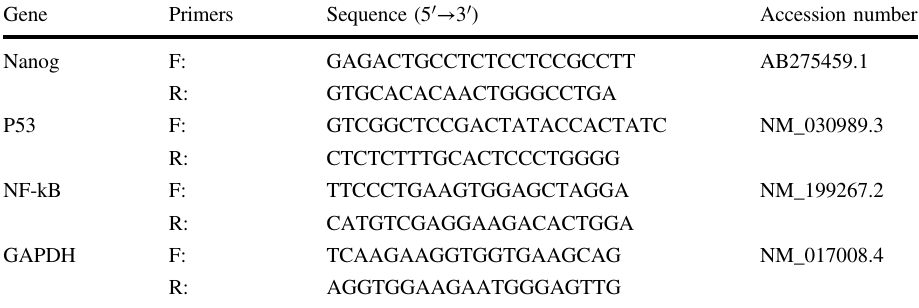
Table 1 Sequences of primers for real-time PCR analysis of mRNAs